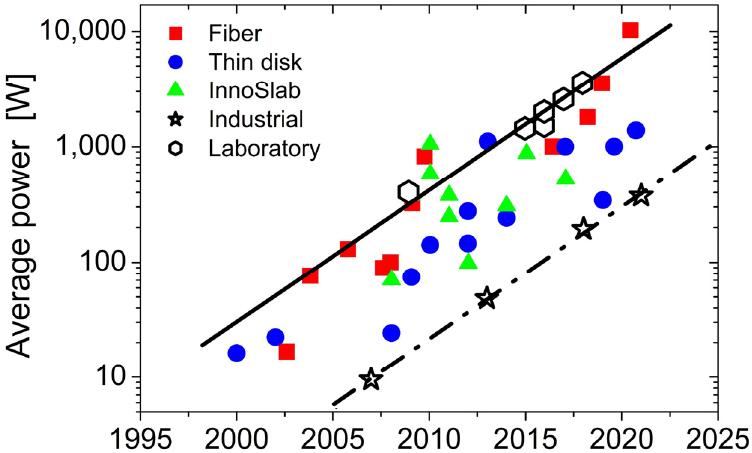
Figure 1. Progress in ultrafast laser technology featuring an exponential increase in the average output power over the past 20 years. The plot is a synthesis of data, indicating the related laser technology (fiber, thin disk, and InnoSlab) as fully colored data points [2], as well as their realization in laboratories or as commercial industrial products as open black data points [3]. The black lines guide the eye.